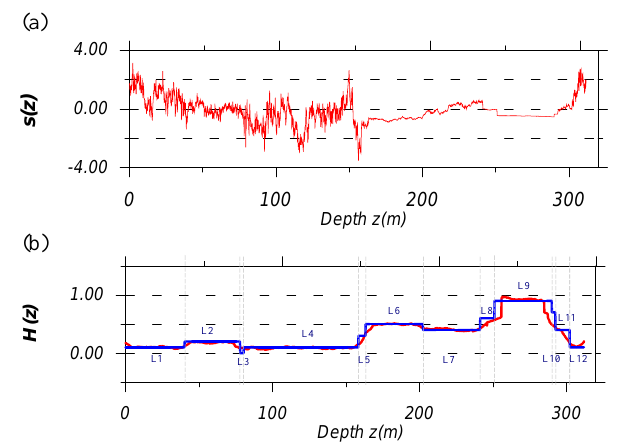
Figure 1. Histograms of the Hurst values obtained by the three methods: (a) LWA (b) ALWA2 (c) PA, from 1000 realizations of a synthetic nhBm s(z) corresponding to a four-layer3 geological model at the position (z=121.77m), located in the second layer (theoretical H-value4 =0.4).5